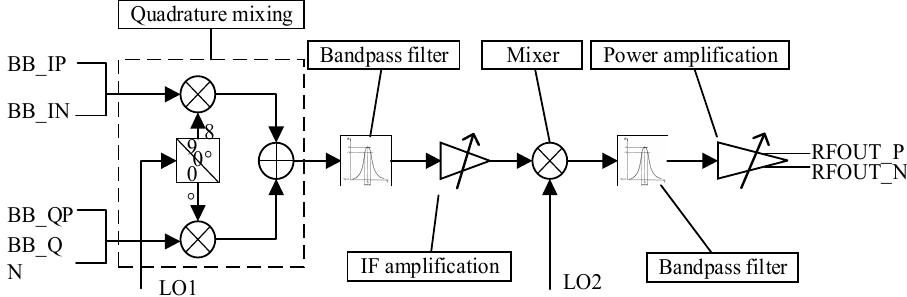
Figure 5. Schematic block diagram of the emission pathway [5–9,21].